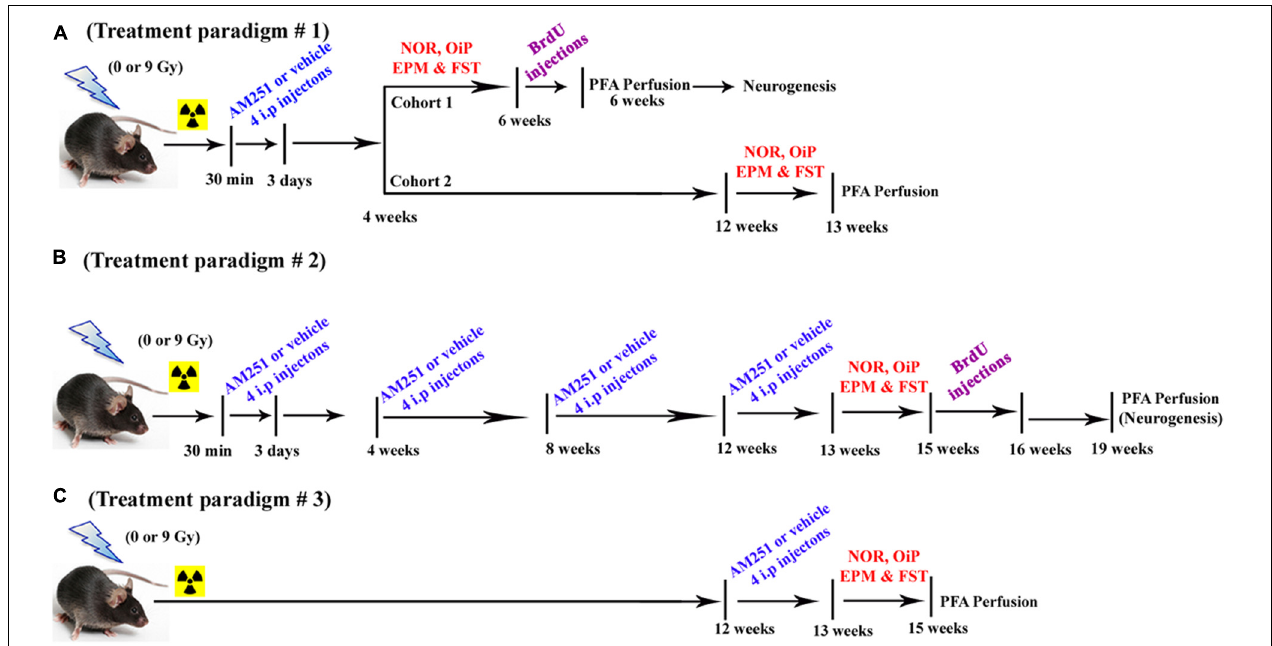
FIGURE 1 | Timeline of AM251 treatments and analyses. (A) Short-term, (B) long-term, and (C) delayed AM251 treatment paradigms used in this